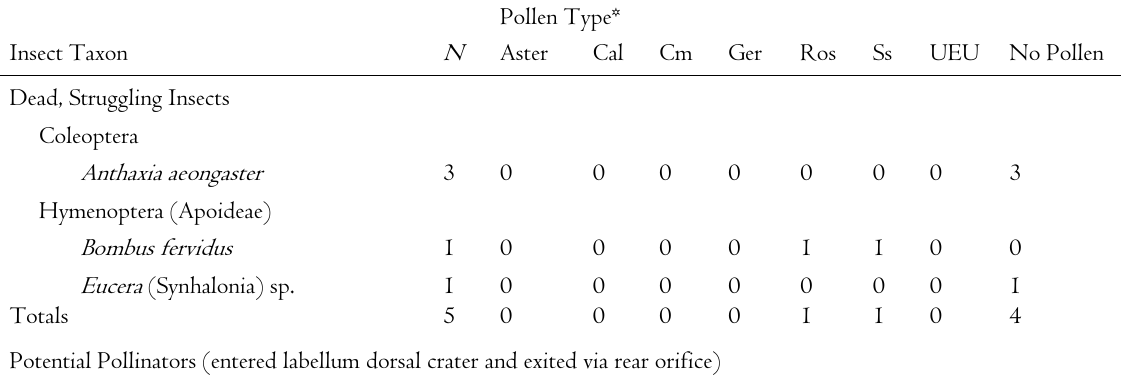
Table 4. Pollen load analyses of insects collected in the labella of Cypripedium montanum or as they exited via the rear orifices at the BMEO site in